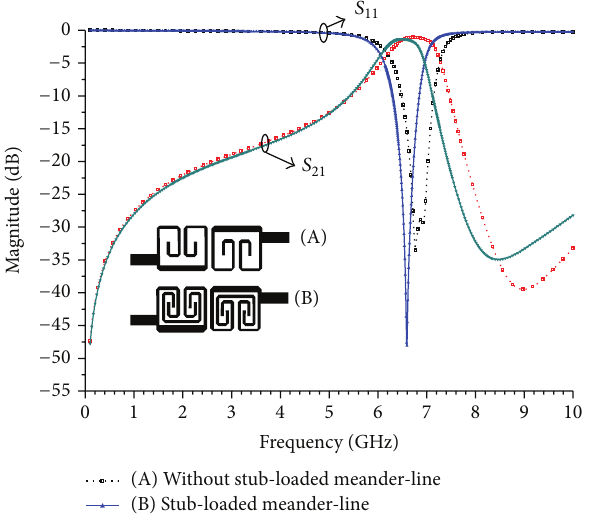
Figure 4: The comparison of the simulated structure, (A) without the stub-loaded meander-line and (B) the stub-load meander-line.